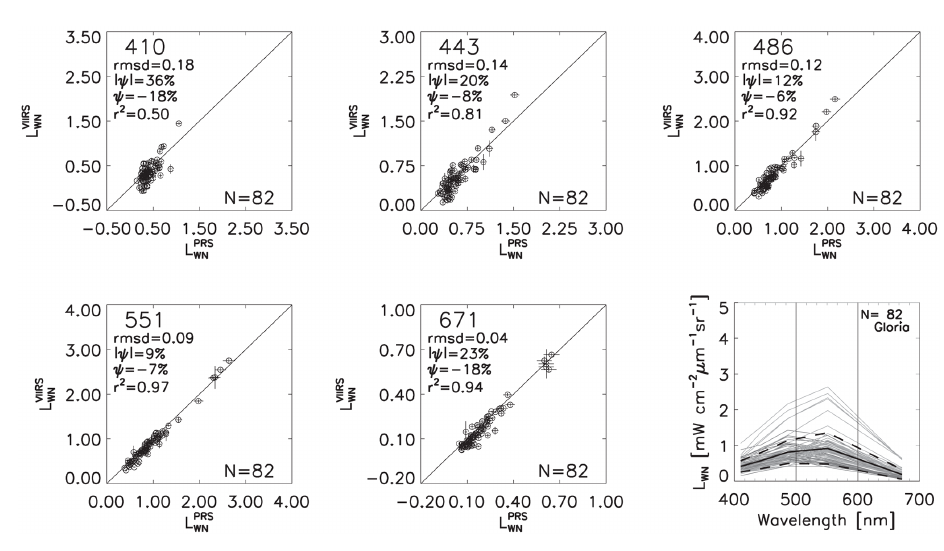
Figure 5. As in Fig. 4 but for VIIRS match-ups at